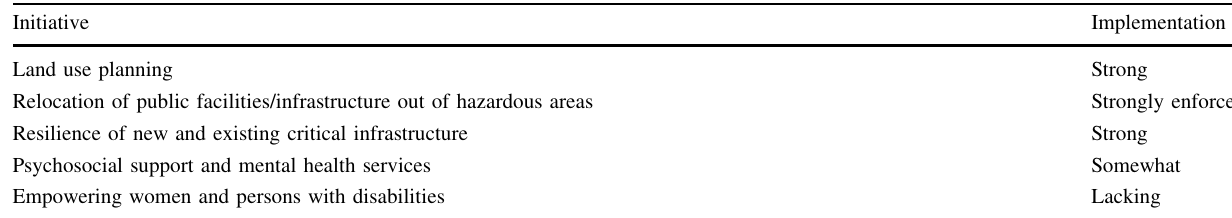
Table 2 Evaluation of the Great East Japan Earthquake recovery by initiatives promoted in Sendai Framework Priority 4 Initiative